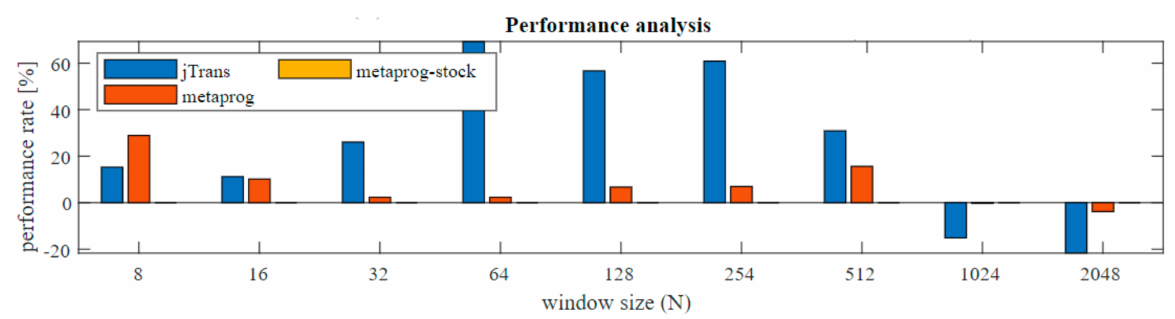
Figure 7. Performance improvement test results for STFT solutions (metaprog-stock as